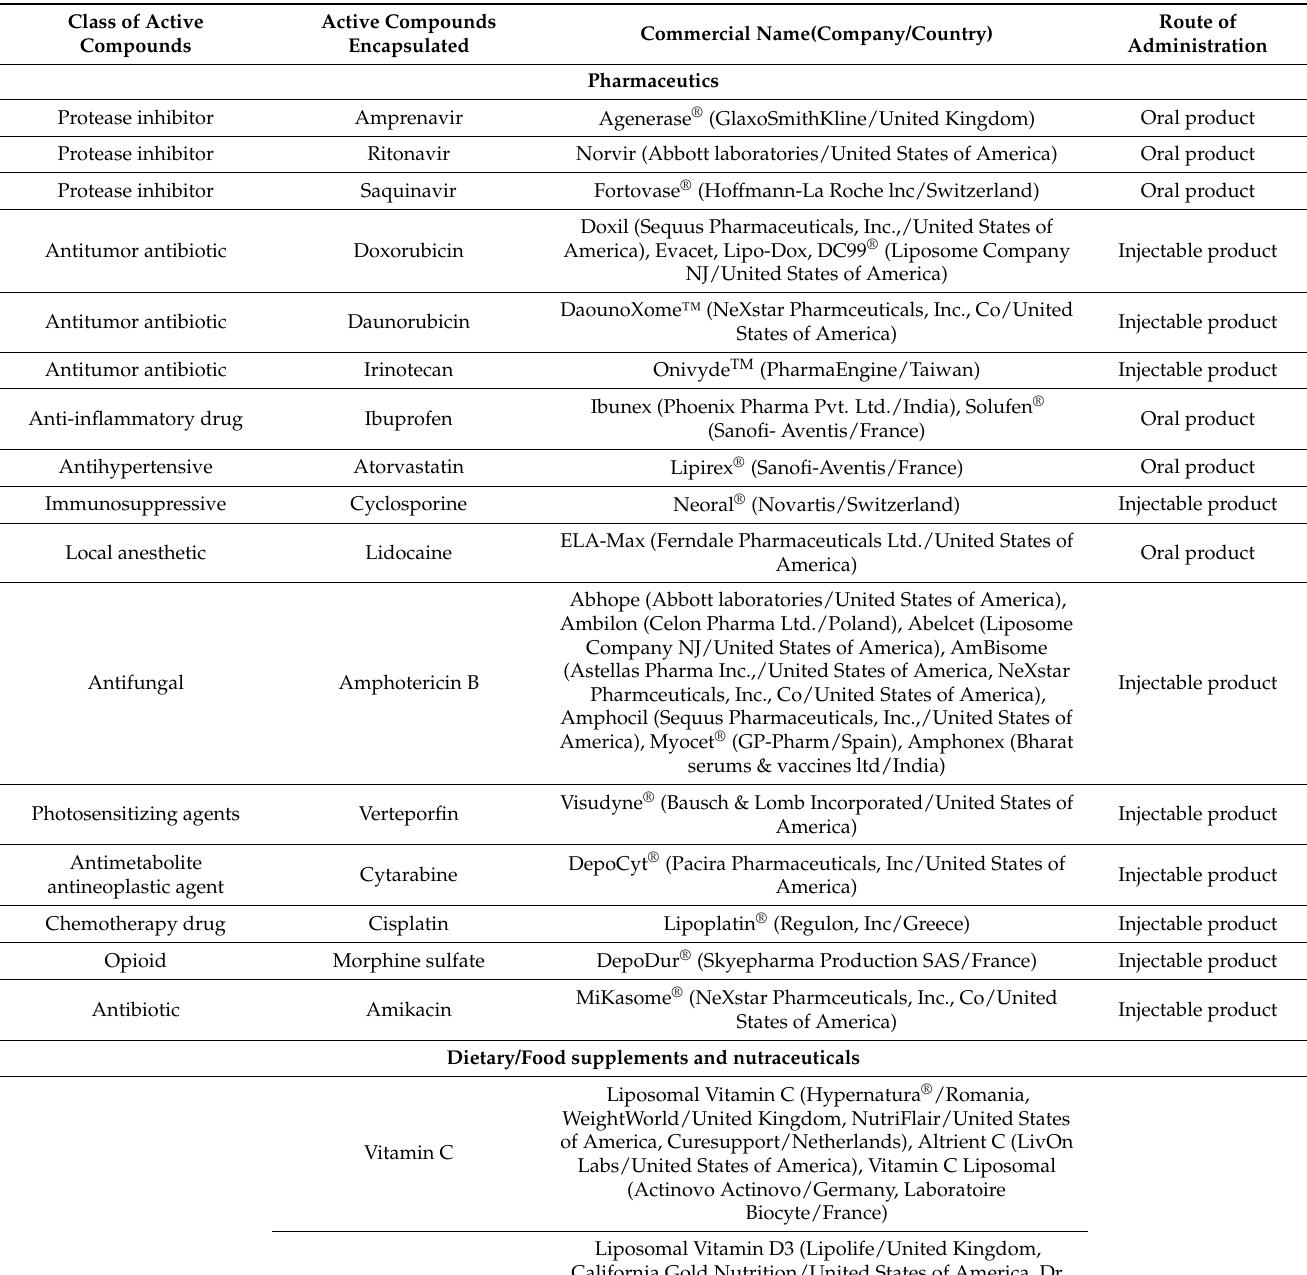
Table 7. Liposome commercial products available on the